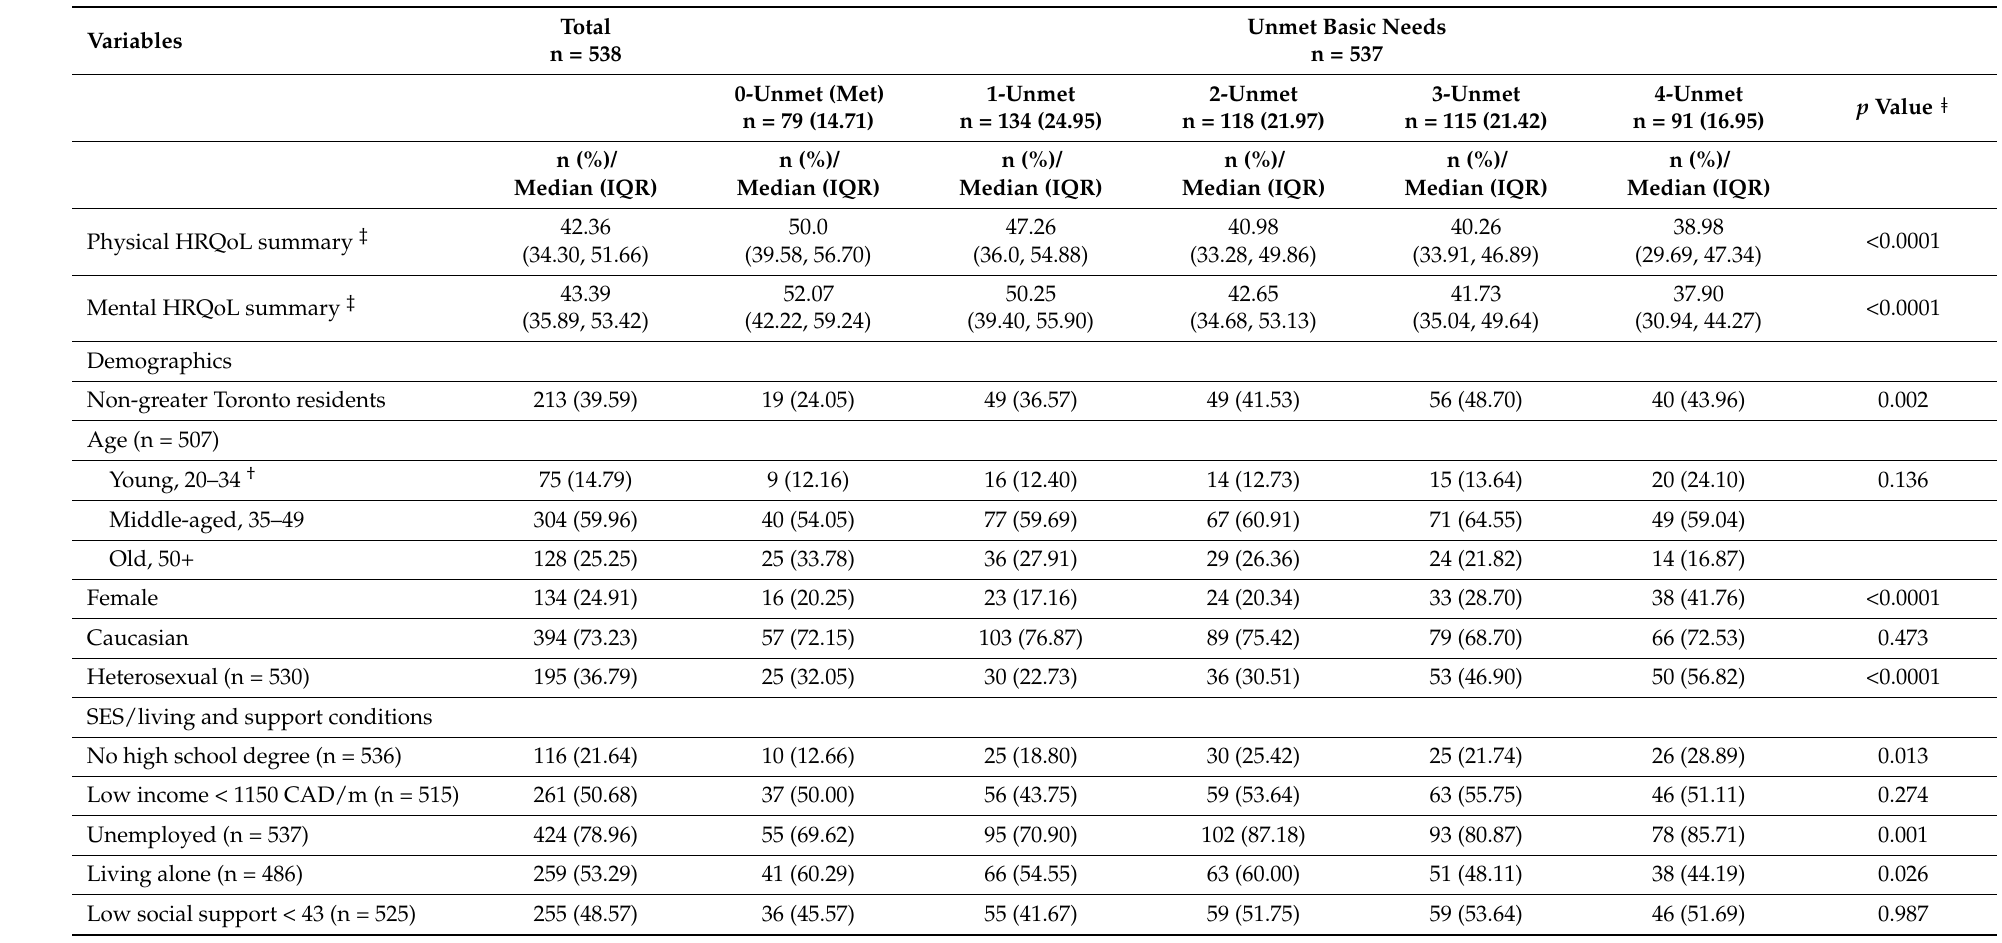
Table 1. Baseline sample characteristics (2006) in Positive Spaces, Healthy